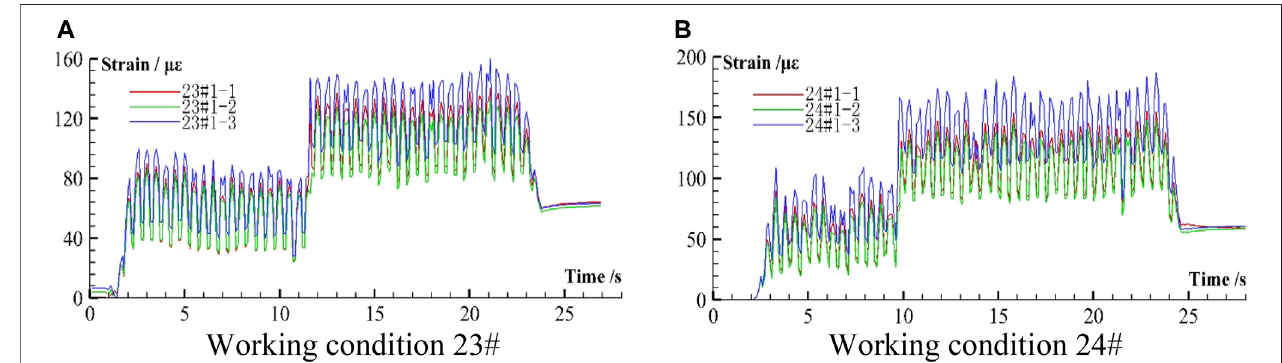
FIGURE 10 | Time history curves of strain of anti-seismic anchor cables in instantaneous slip situation. (A) Working condition 23#. (B) Working condition 24#.